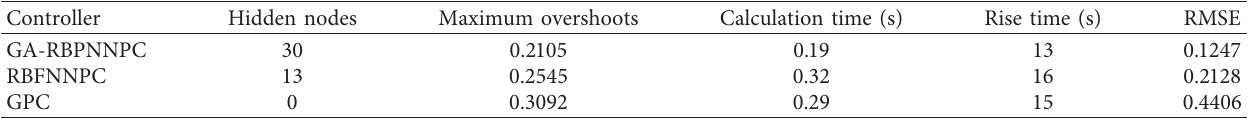
Table 6: Comparison of the performance of different